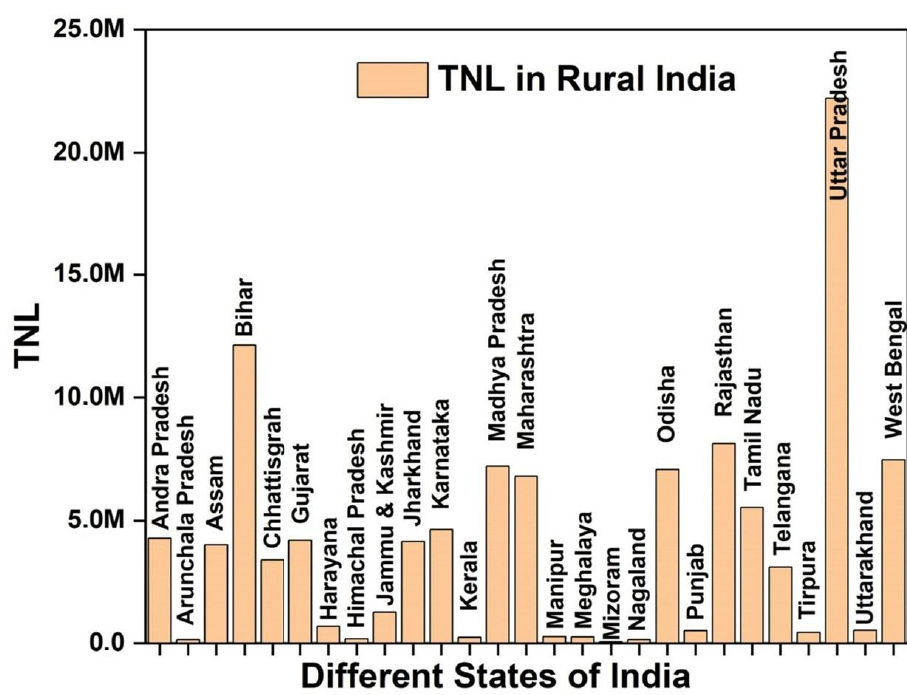
Figure 2. Bar chart depicting the total number of lavatories (TNL) built through SBM (‘M’ = 10 6 ). Data for this chart are extracted from the Ministry of Jal Shakti of GOI [16].